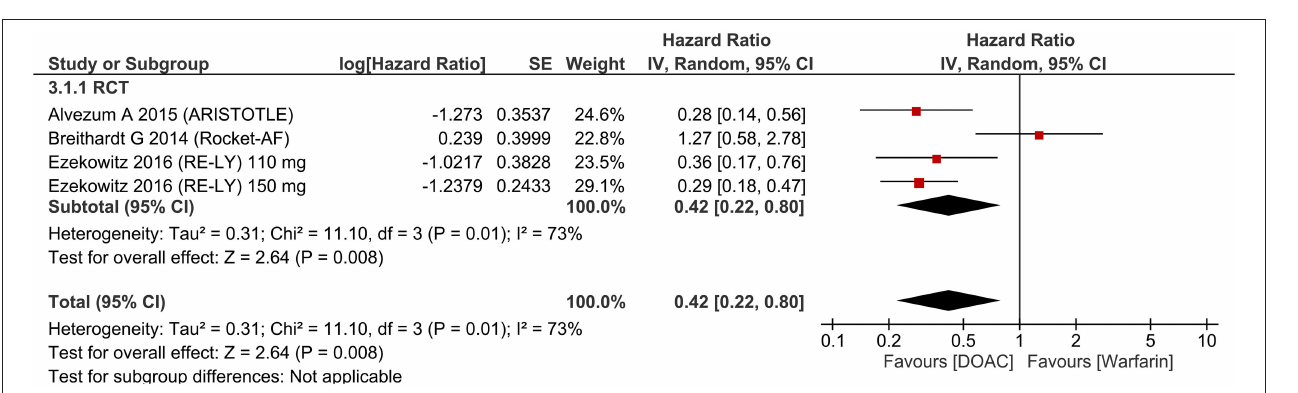
FIGURE 4 | Intracranial